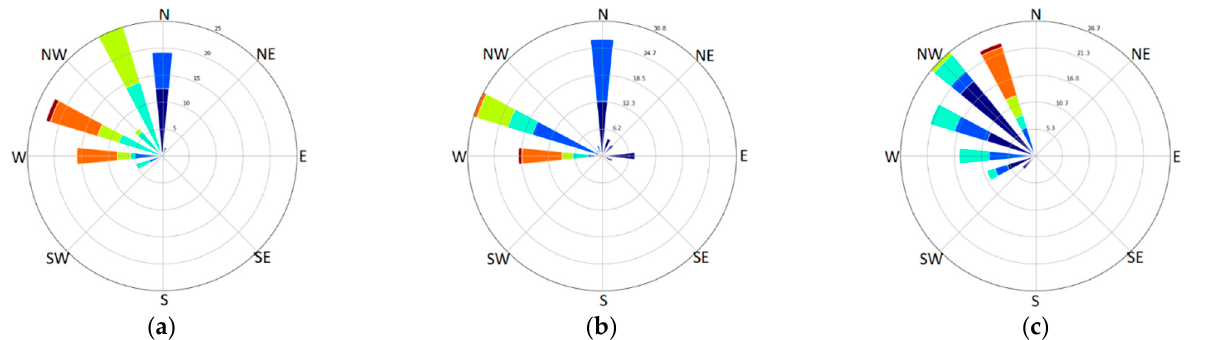
Figure 8. Roses of the distribution of the direction of the significant wave for 5 days before the moment of observation: ( a ) for case No. 8; ( b ) for case No. 18; ( c ) for case No. 21.